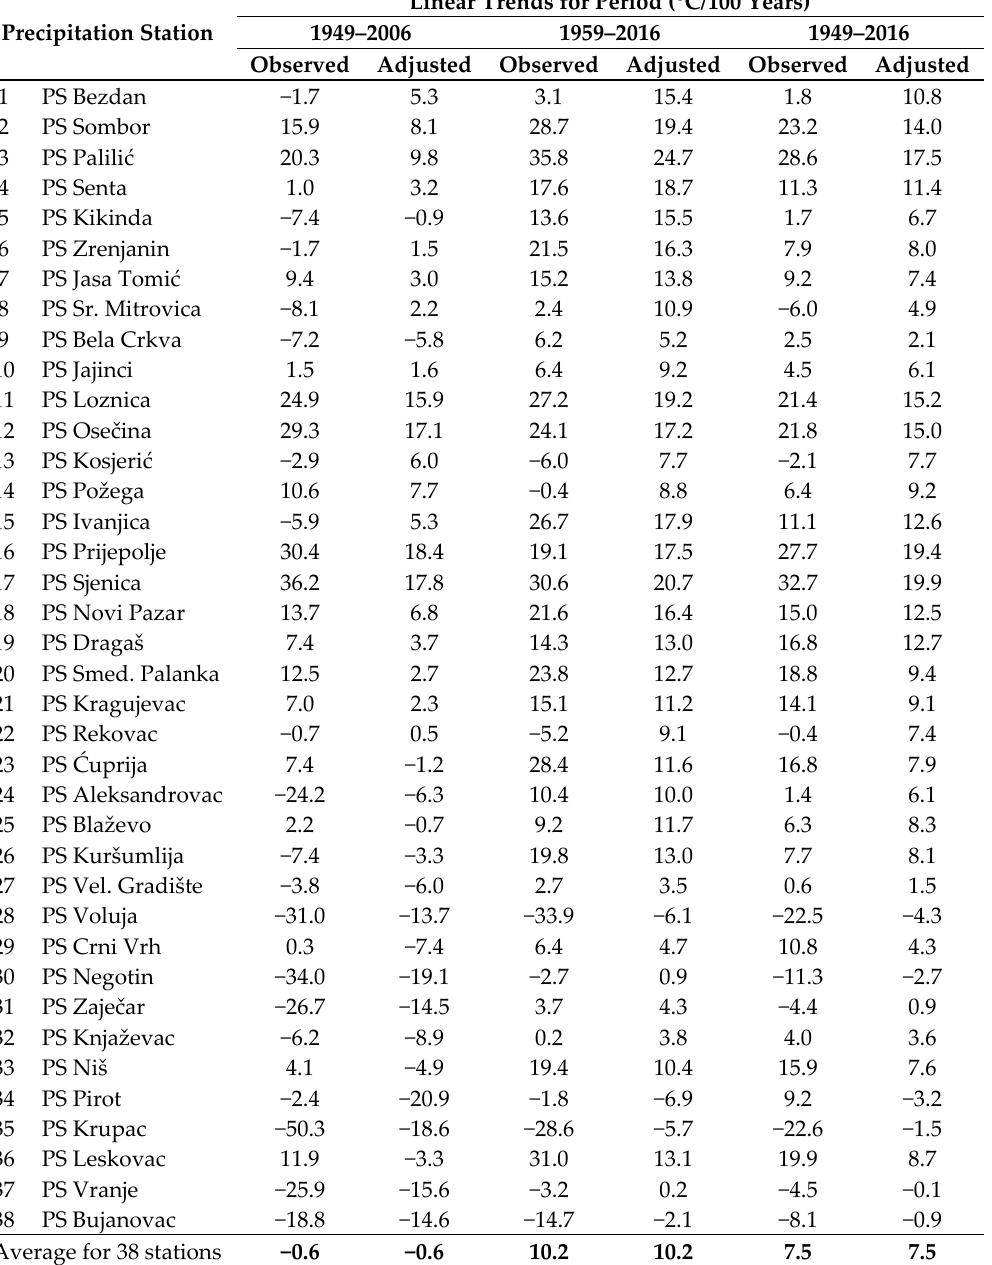
Table 2. Selected P stations with observed and adjusted annual trends for analyzed